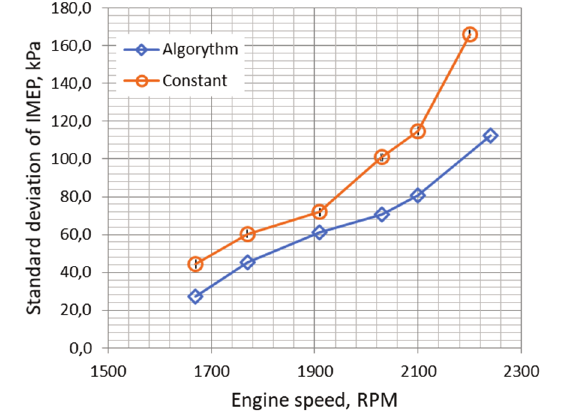
Fig. 7. Relationship between standard deviation of IMEP and rotational speed for constant and variable ignition advance angle